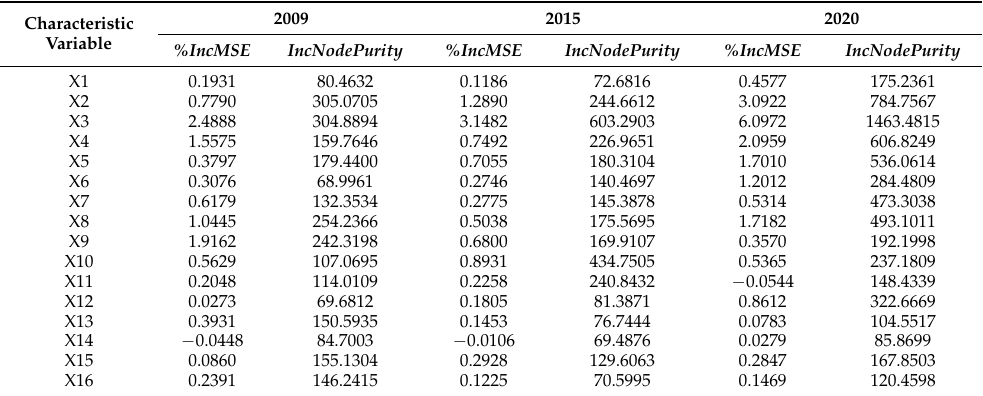
Table 5. Detection results of the influencing factors of PIR in China. Characteristic